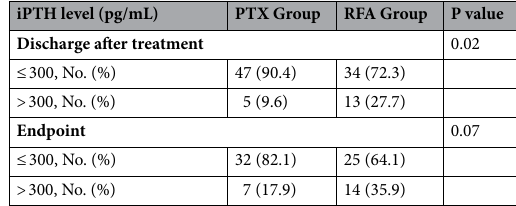
Table 2. Proportion of patients achieving and not achieving the target range iPTH concentration by treatment